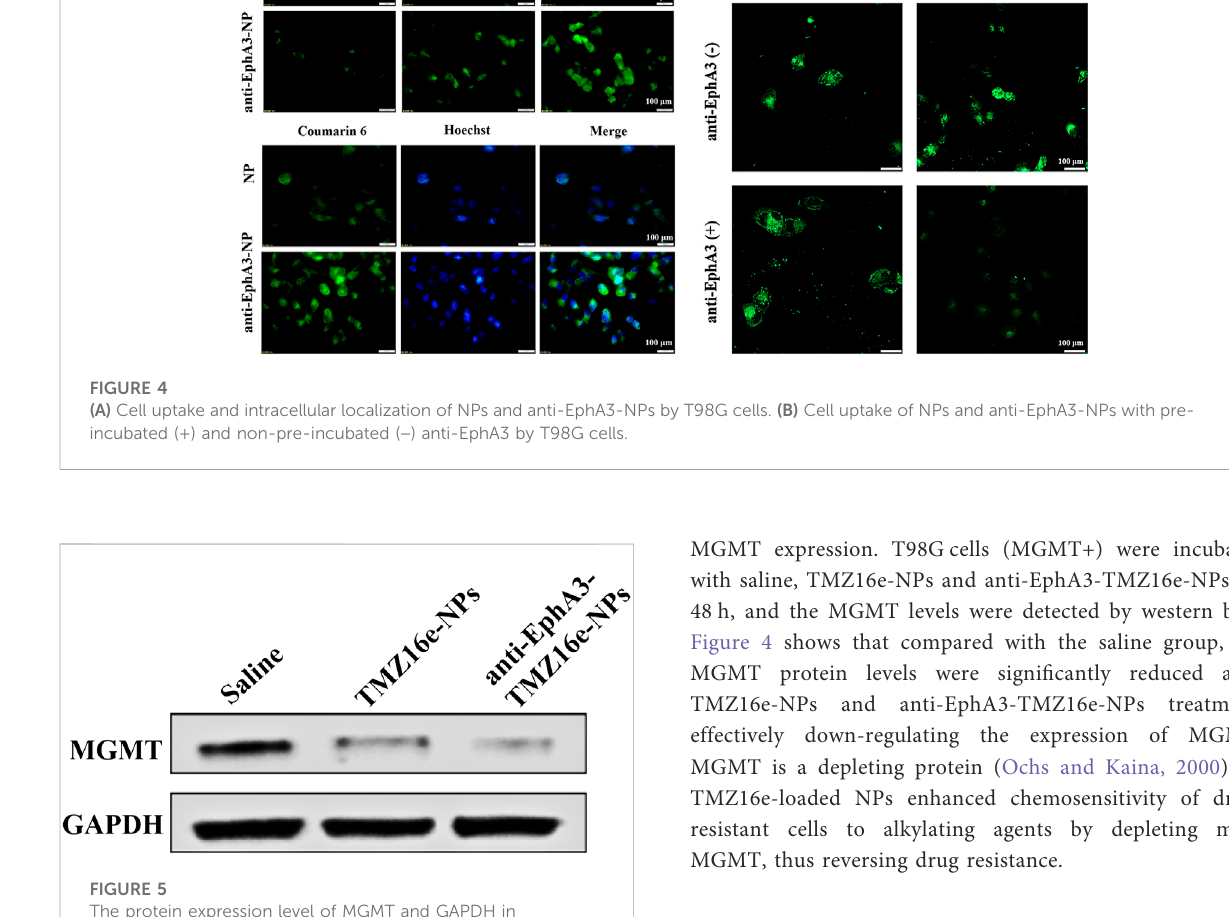
FIGURE 5 The protein expression level of MGMT and GAPDH in T98G cells treated with TMZ16e-NPs and anti-EphA3-TMZ16e- NPs ( n =